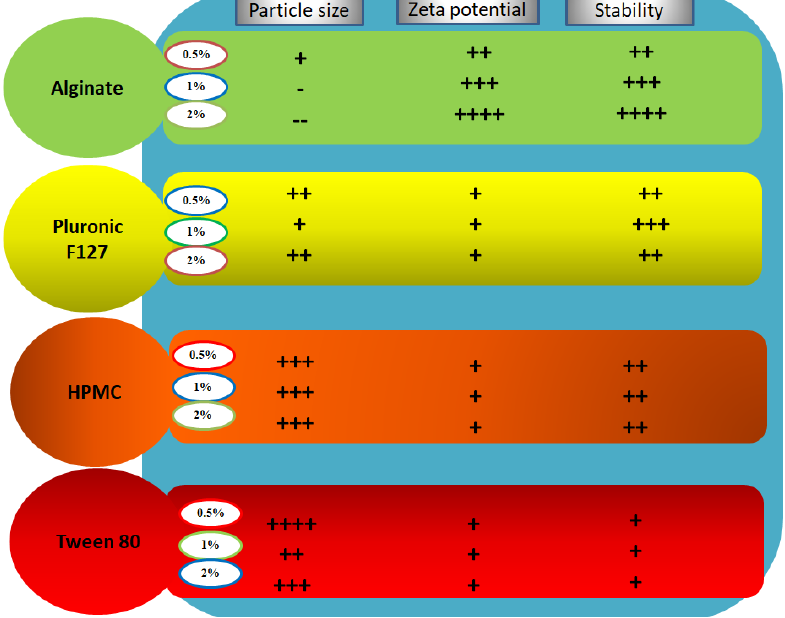
Figure 3. Summative representation of the results of stability studies of LT-loaded nanosuspensions.